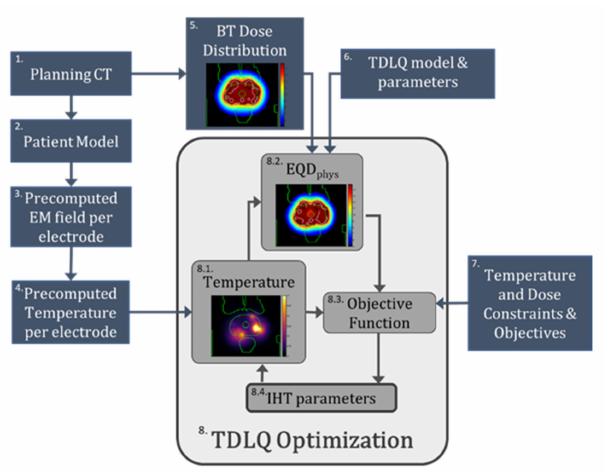
Figure 1. Graphical summary of the proposed optimization framework. 1. The planning CT is the initial input of the process. 2. The patient model is generated. 3. The EM field per electrode is precal- culated. 4. The temperature distribution per electrode is precalculated. 5. The BT dose distribution is imported from the BT treatment planning software. 6. The TDLQ model is used for the calculation of the combined effect. 7. Both temperature and dose constraints and objectives are used for the optimization process. 8. The TDLQ optimization process optimizes the IHT parameters (8.4) that generate a temperature distribution (8.1) from which an EQD phys distribution is generated (8.2). This EQD phys distribution is used to compute the objective function, which needs to be minimized (8.3).